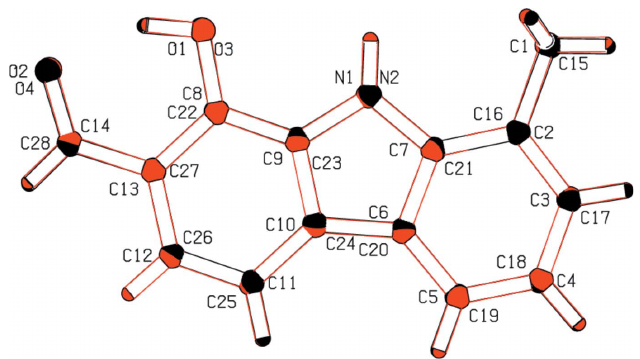
Figure 2 Least-squares overlay of the two independent molecules (inverted